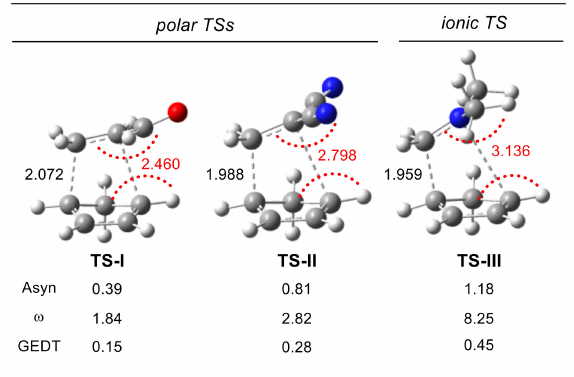
Figure 2. B3LYP/6-32G(d) Asynchronicity, Asyn = d1-d2 in Angstroms, Å, electrophilicity ω index of the ethylene, in eV, and GEDT, in e, at the TSs involved in P-DA reactions, TS-I and TS-II , and in I-DA reaction, TS-III